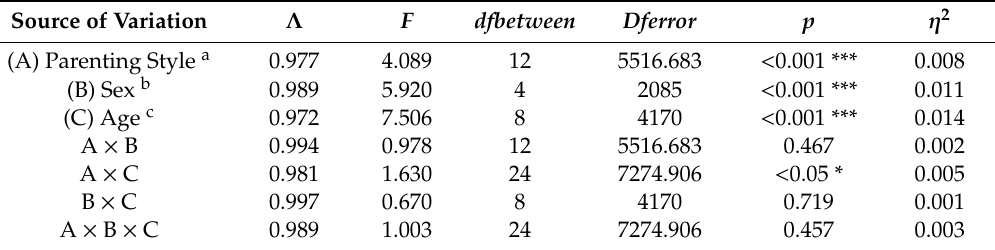
Table 2. MANOVA results for all the studied variables (4 a × 2 b × 3 c ).